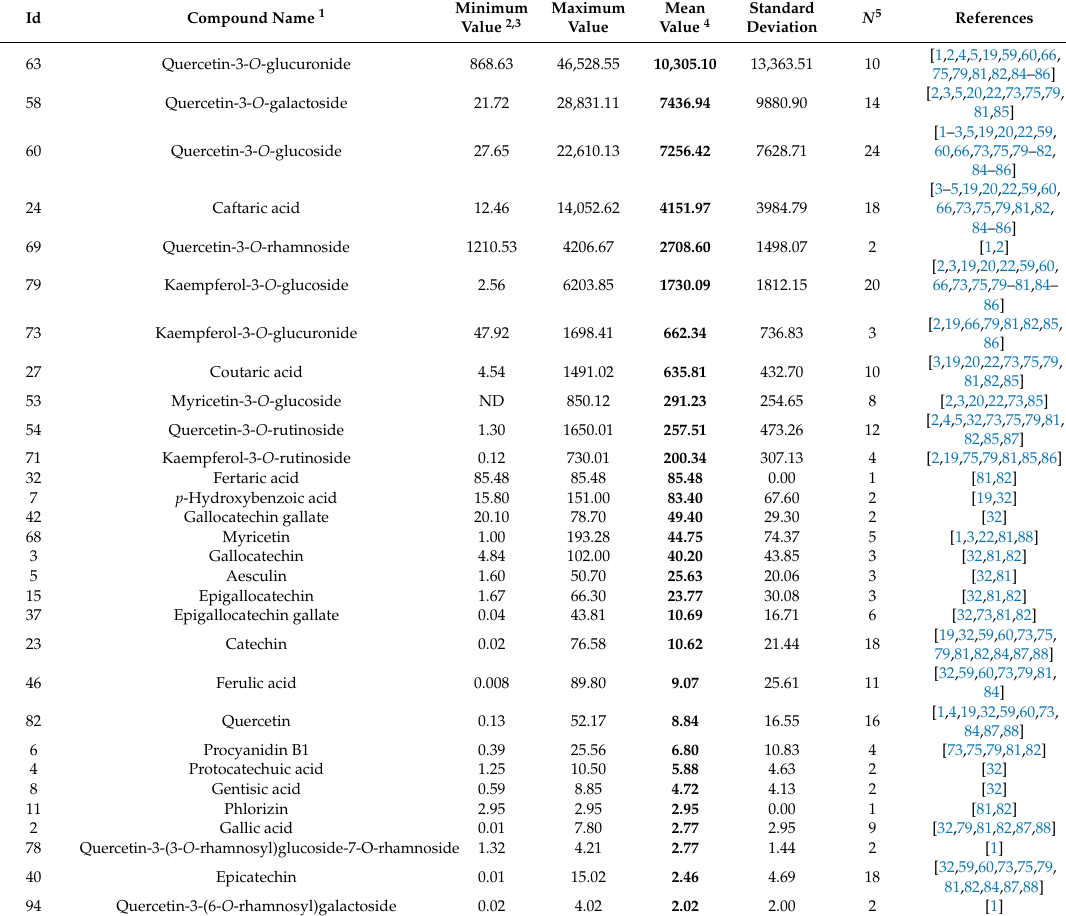
Table 3. Levels (mg / kg) of 92 polyphenols (excluding stilbenes) identified in grapevine